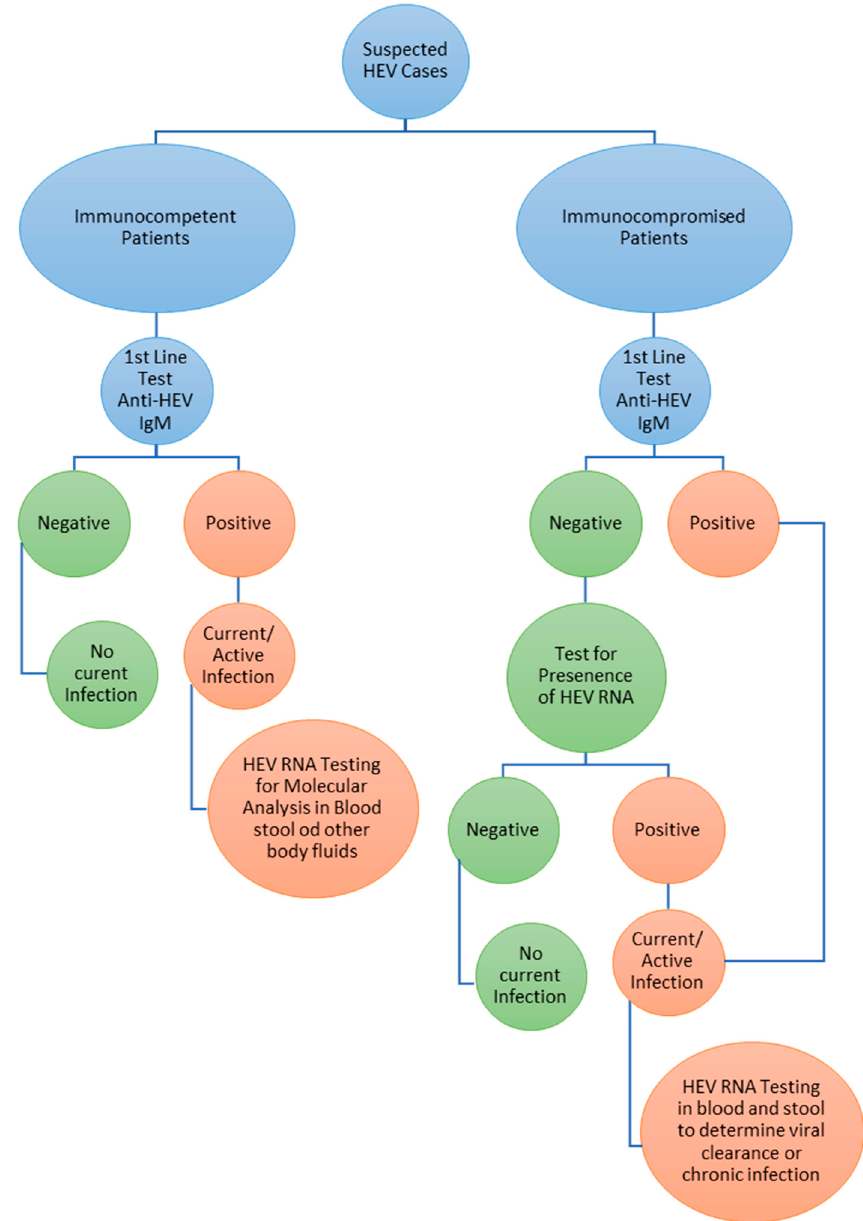
Figure 5. Diagnostic algorithm of HEV infection [3].